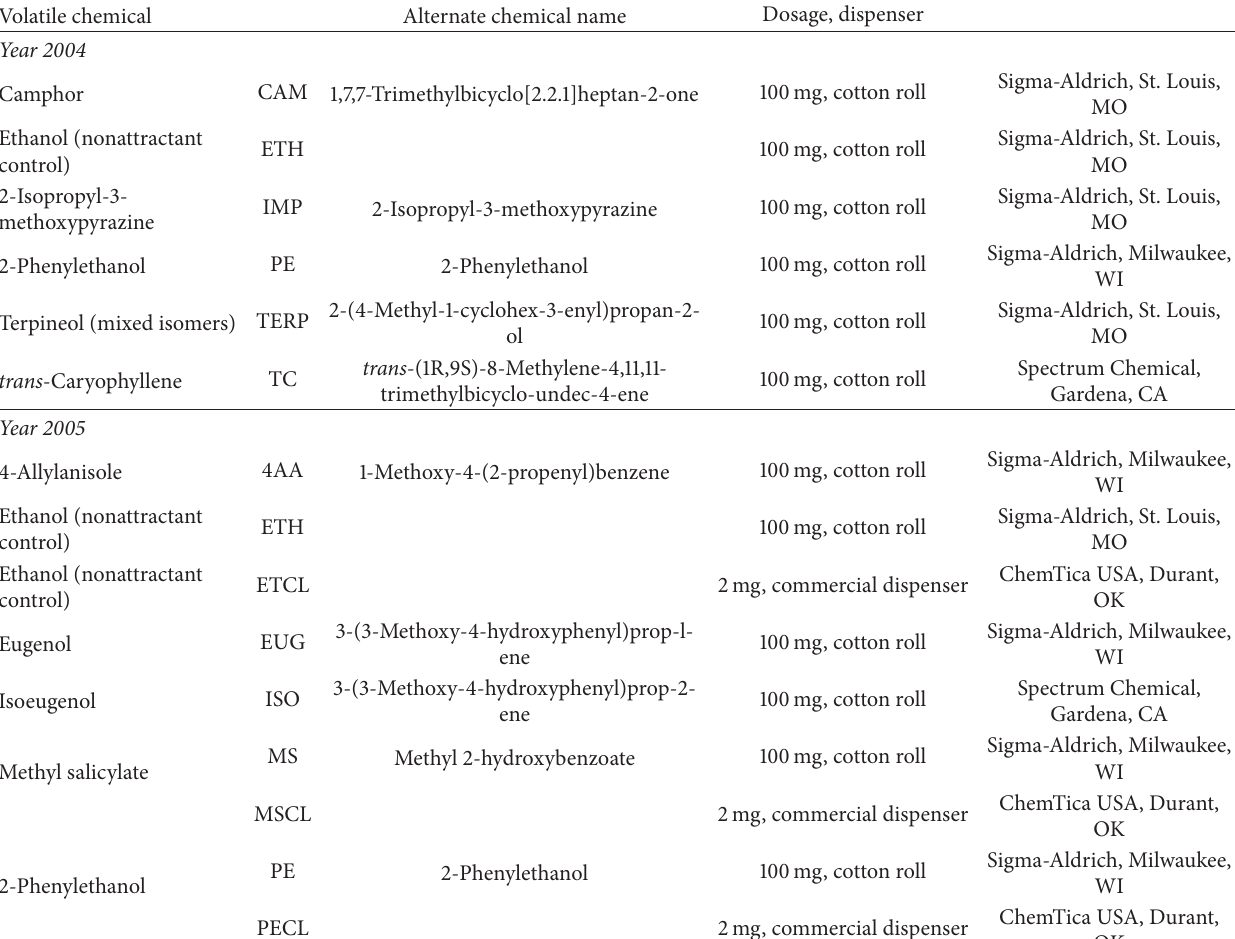
Table 1: Volatile chemicals tested for attraction to beneficial insects in agricultural plots near Brookings,